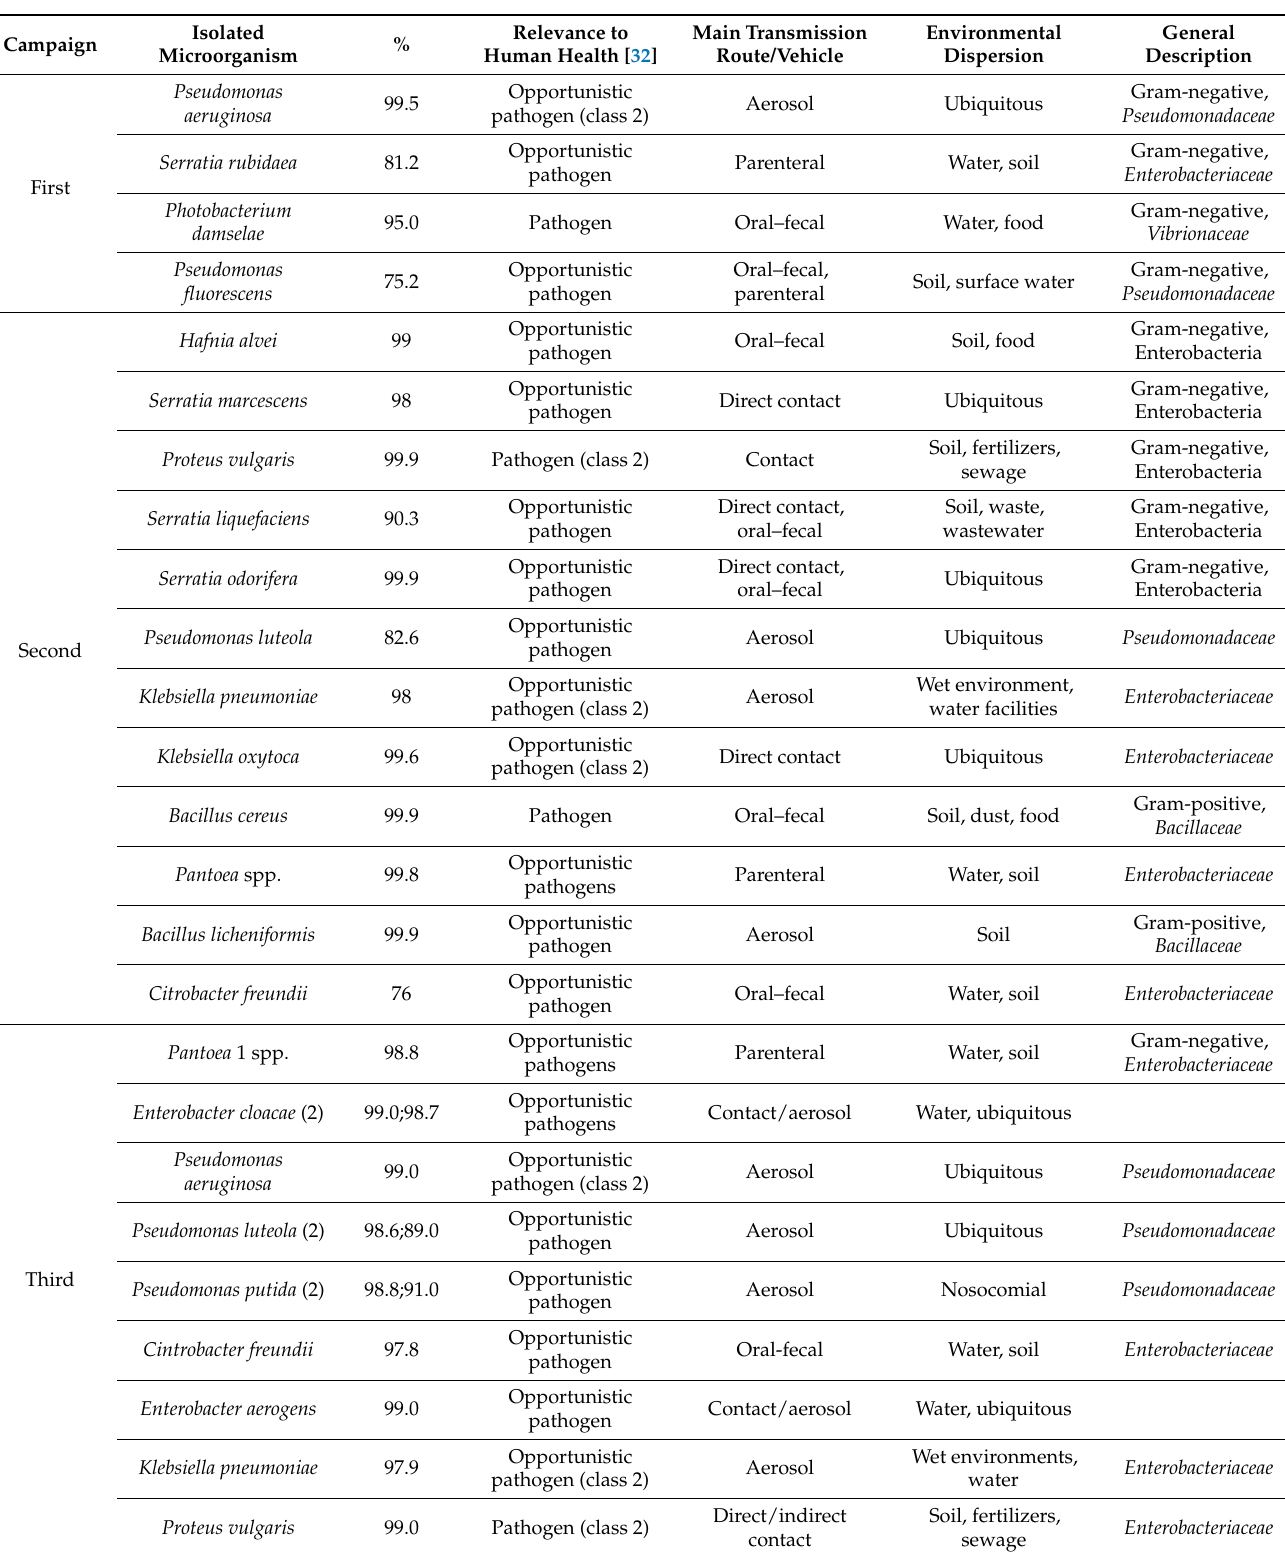
Table 4. Microorganisms isolated through rapid biochemical tests (API, bioM é riux) in all three sampling campaigns. % indicates percentage